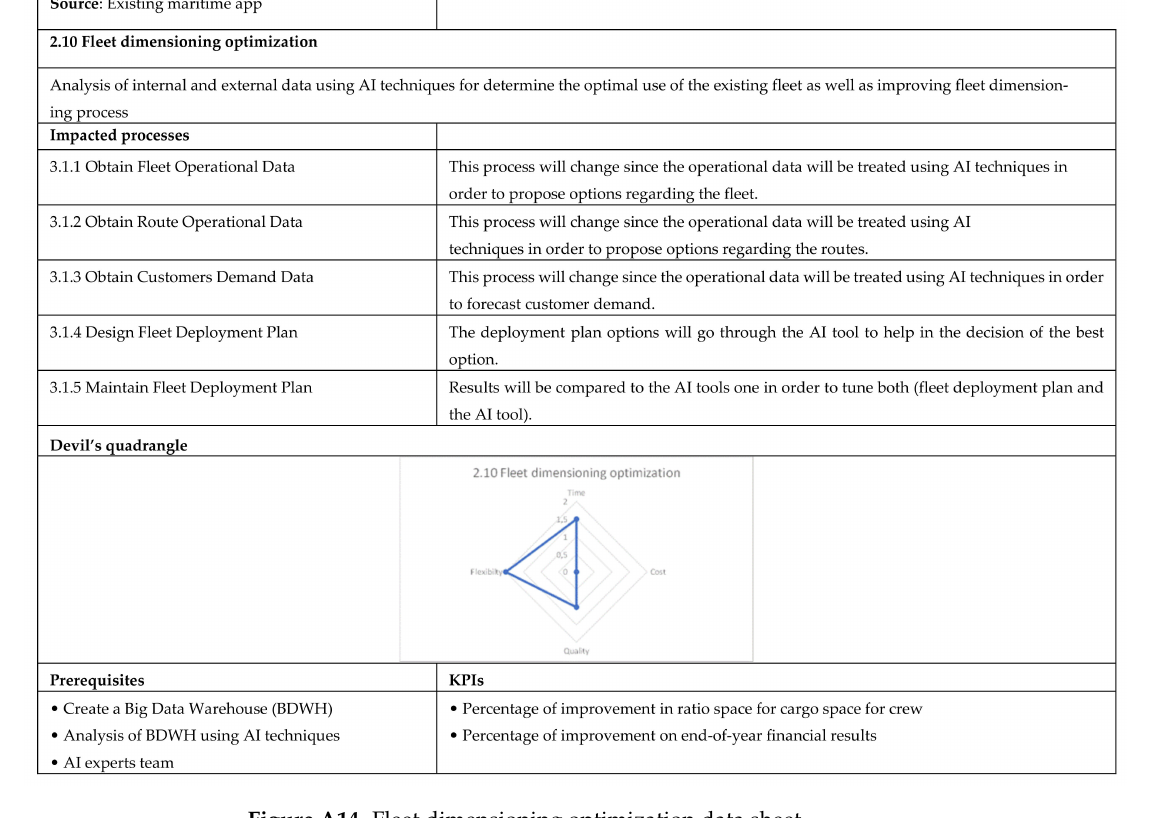
Figure A14. Fleet dimensioning optimization data sheet.